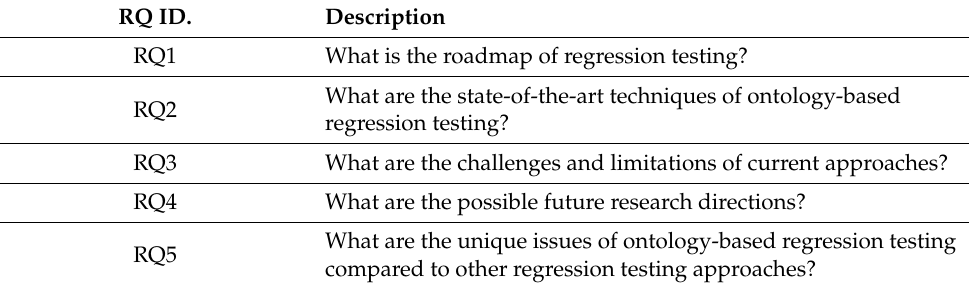
Table 2. Proposed research questions.